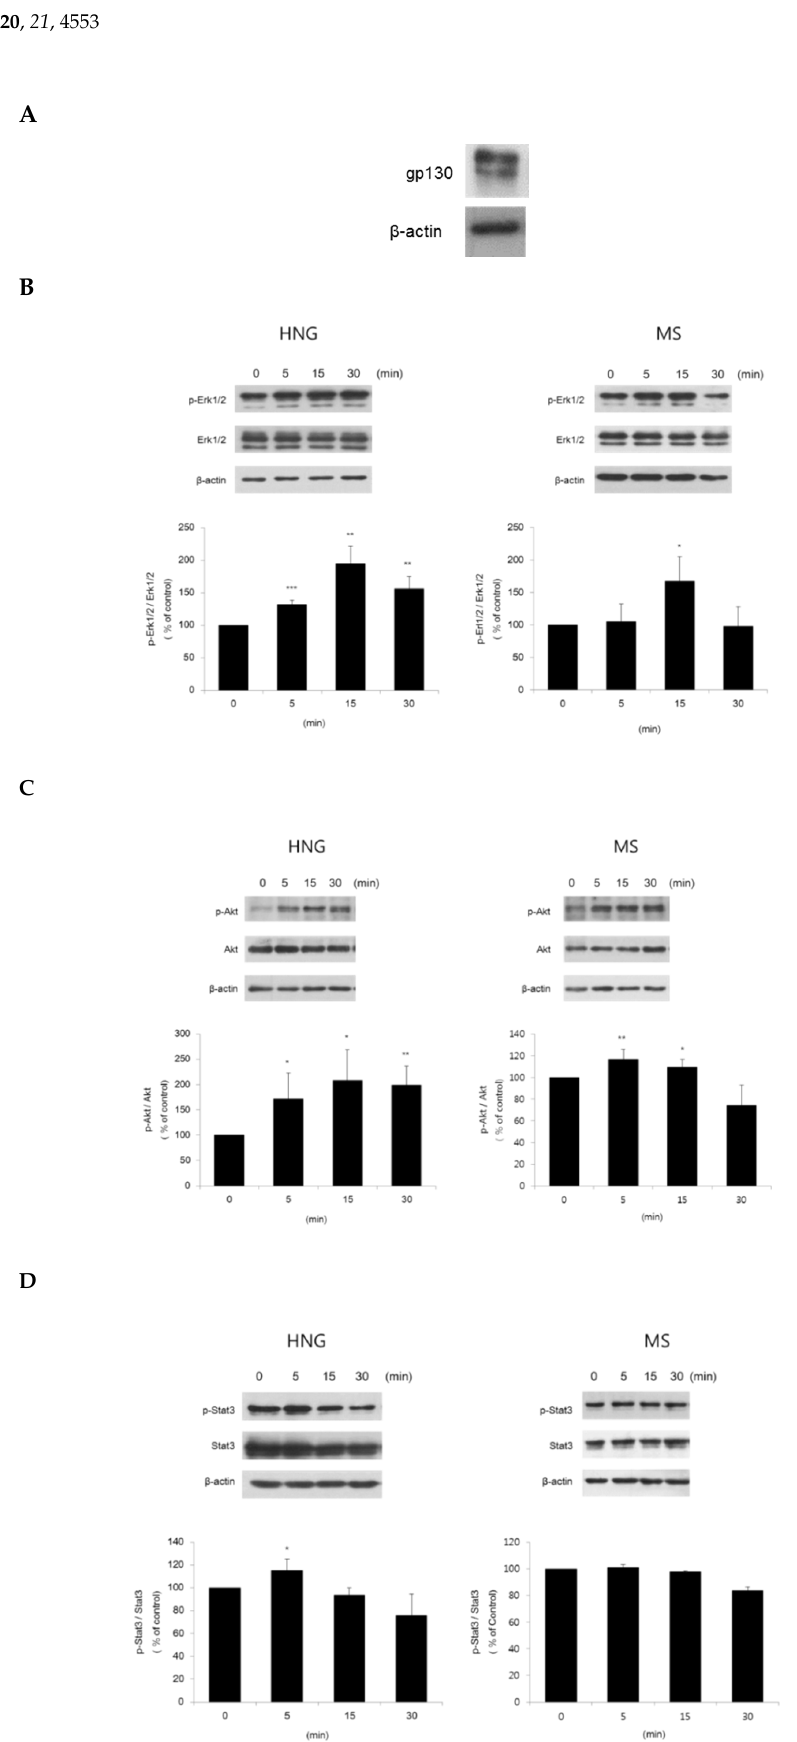
Figure 4. Extracellular signal-regulated kinase (Erk)1 / 2, Akt, and signal transducer and activator